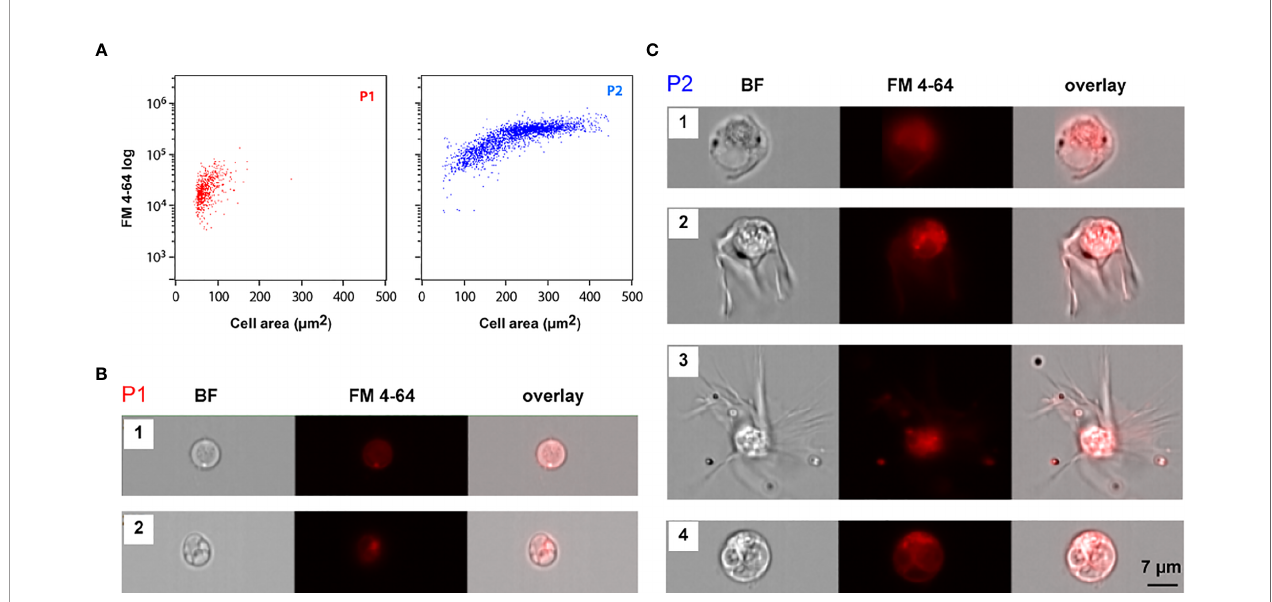
FIGURE 4 | Imaging fl ow cytometry morphologic analysis of circulating coelomocytes. (A) IFC dot plots showing cell area and FM 4-64 intensity values of P1 (red) and P2 (blue) cell populations. (B, C) Bright fi eld (BF) and FM4-64 fl uorescence IFC images for the several morphotypes detected within each coelomocytes population, P1 (B) and P2 (C) . Coelomocytes membranes were stained with FM 4-64 (red). B1. P1 cells displaying a less heterogenous bright fi eld image with the nucleus occupying the majority of the cell area ( Figure 5A3 ) B2. P1 cells with a heavily granulated cytoplasm displaying a smaller nucleus to cell ratio ( Figures 5A1, A2 ); C1. P2 regular; C2. P2 petaloid C3. P2 fi lopodial coelomocytes; C4. Big granulated